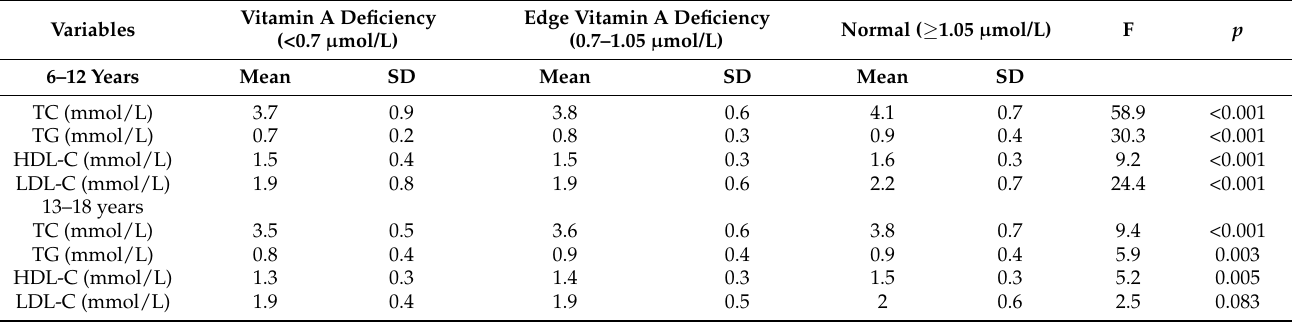
Figure 2. Change in blood lipids with age for different sexes. Means and standard error of the means are shown. ( A ) Change in TC with age. ( B ) Change in TG with age. ( C ) Change in HDL-C with age. ( D ) Change in LDL-C with age. Table 2. Blood lipid values according to age group and vitamin A status (mean values and standard